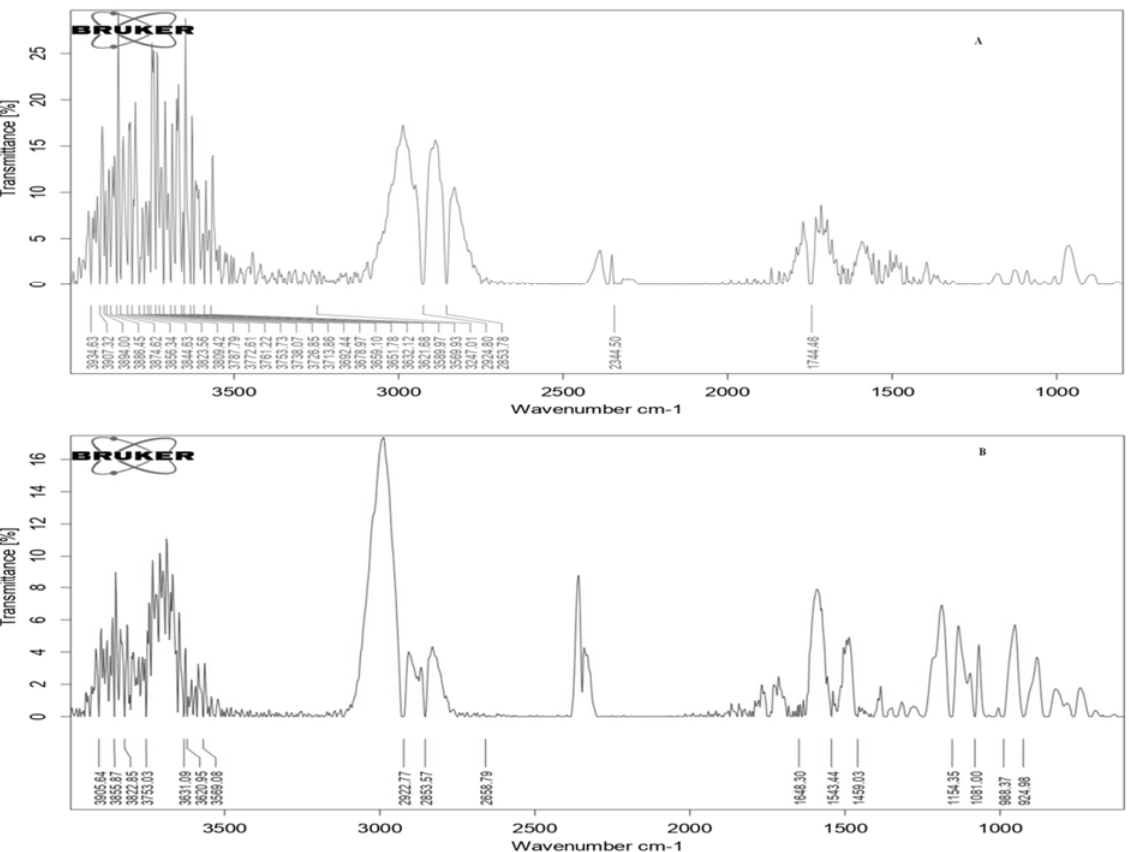
Figure 4. Fourier Transform Infrared Spectroscopy spectra of ( A ) RFR and ( B ) CCRFR.